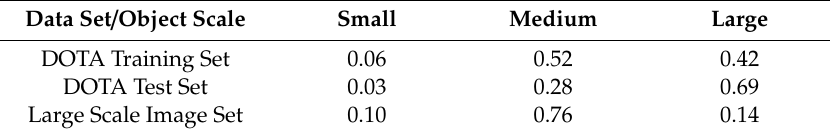
Table 3. The ratios (%) of data sets according to the object